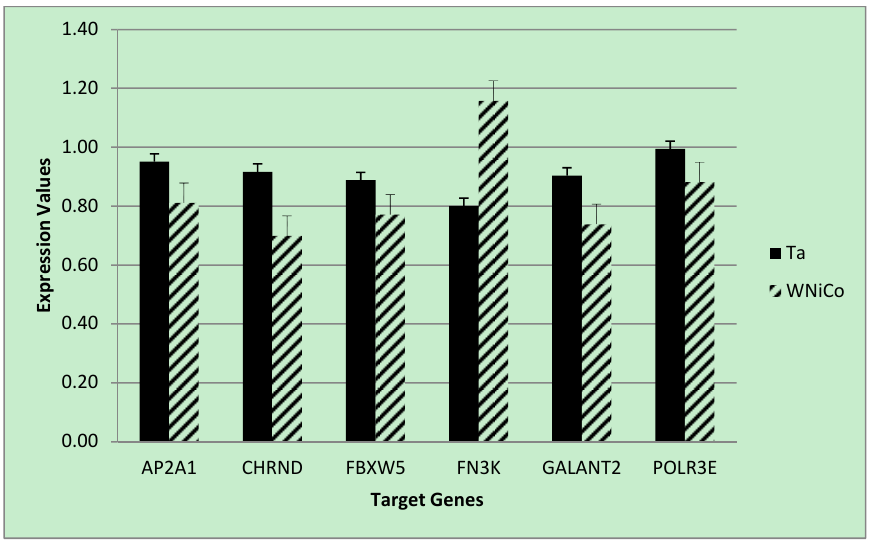
Figure 6. PCR expression values for selected genes for the Ta control and WNiCo groups. Data are the mean of three measurements. Error bars represent standard error.